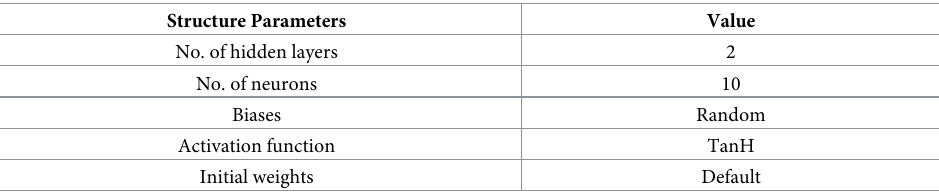
Table 2. Parameters of the NN